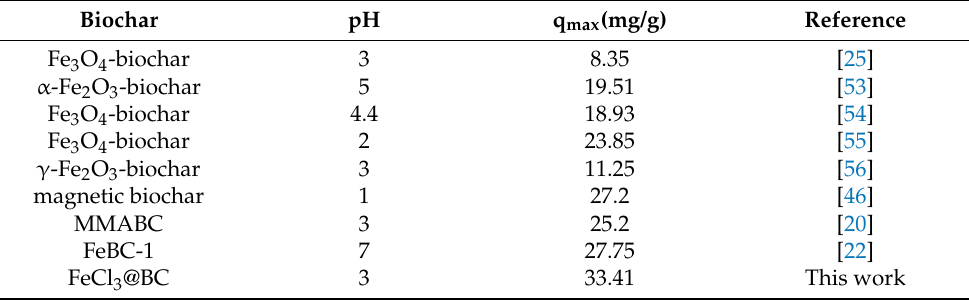
Table 4. Evaluation of adsorption capacities of different biochar for